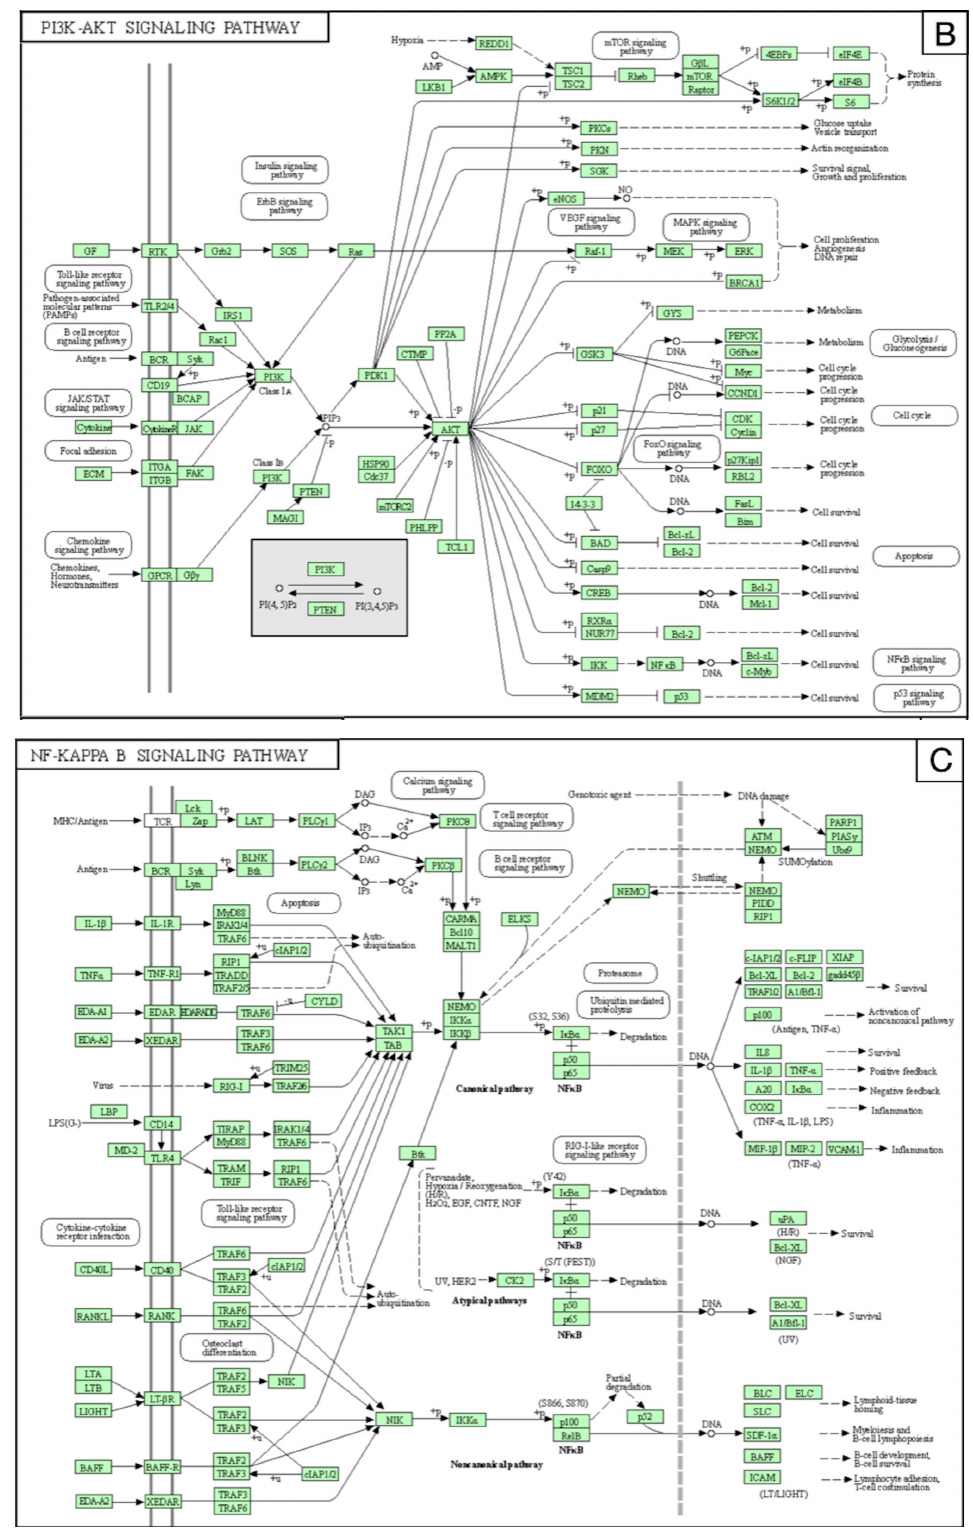
Figure 10. ( A ) The RAS proteins function as molecular switches for signaling pathways regulating cell proliferation, survival, growth, migration, differentiation, or cytoskeletal dynamism. Ras proteins transduce signals from extracellular growth factors by cycling between inactive nucleotide guanosine diphosphate (GDP)-bound and active nucleotide guanosine diphosphate triphosphate (GTP)-bound states. The exchange of GTP for GDP on RAS is regulated by guanine nucleotide ex- change factors (GEFs) and GTPase-activating proteins (GAPs). Activated RAS (RAS-GTP) regulates multiple cellular functions through effectors including Raf, phosphatidylinositol 3-kinase (PI3K), Ral guanine nucleotide-dissociation stimulator (RALGDS), calcium signaling pathways, cell endo- cytosis, migration, and survival. ( B ) The phosphatidylinositol 3 ′ -kinase (PI3K)-Akt signaling path- way is activated by many types of cellular stimuli or toxic insults and regulates fundamental cellular functions such as transcription, translation, proliferation, growth, and survival. The binding of growth factors to their receptor tyrosine kinase (RTK) or G protein-coupled receptors (GPCR) stim- ulates class Ia and Ib PI3K isoforms, respectively. PI3K catalyzes the production of phosphatidylin- ositol-3,4,5-triphosphate (PIP3) at the cell membrane. PIP3 in turn serves as a second messenger that helps to activate Akt. Once active, Akt can control key cellular processes by phosphorylating sub- strates involved in apoptosis, protein synthesis, glucose metabolism, and cell cycle. ( C ) Nuclear fac- tor-kappa B (NFkB) is a transcription factor that regulates mechanisms of immunity, inflammation, and cell survival. The canonical pathway of NFkB is activated by the tumor necrosis factor-alpha (TNF-alpha), interleukin-1 (IL-1), or infections. These signals rely on the IkB kinase (IKK)-mediated IkB-alpha phosphorylation on Ser32 and 36, leading to its degradation. This allows the p50/p65 NF- kB dimer to penetrate the nucleus and activate gene transcription. Atypical IKK-independent path- ways rely on the phosphorylation of IkB-alpha on Tyr42 or Ser residues in the IkappaB-alpha PEST domain. The non-canonical pathway is triggered by members of the tumor necrosis factor receptor 1 (TNFR) superfamily, such as lymphotoxin-beta (LT-beta) or B-cell activating factor (BAFF). It in- volves NIK and IKK-alpha-mediated p100 phosphorylation and processing to p52, resulting in the nuclear translocation of p52/RelB heterodimers, involving in B-cell survival and lymphopoiesis.